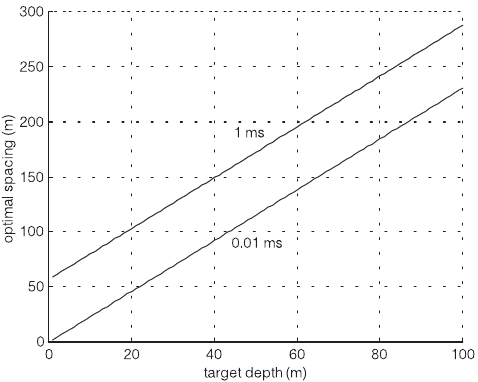
Fig. 6. TX-RX optimal spacing r in function of the tar- get depth.